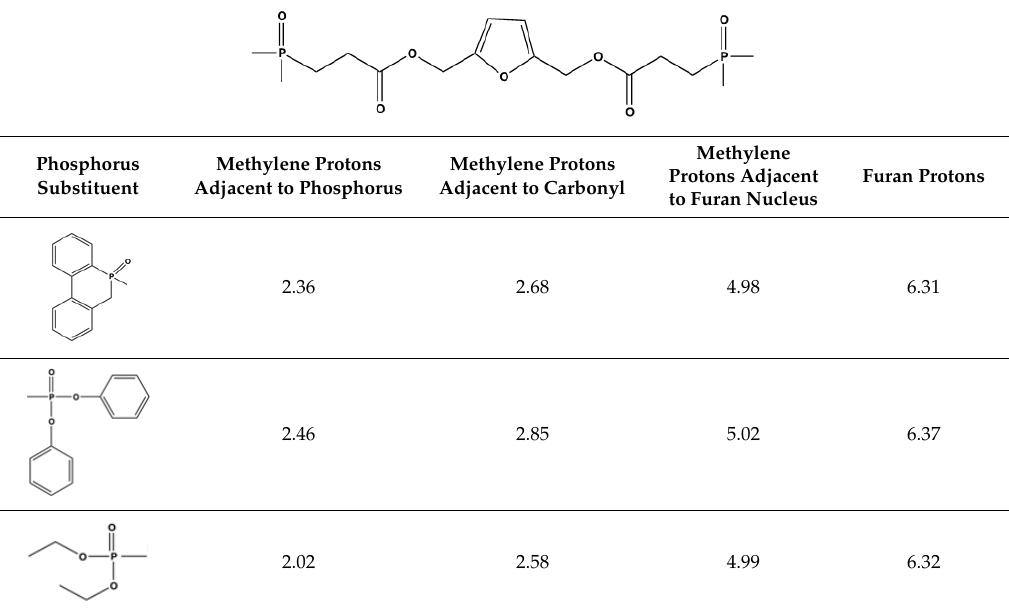
Table 3. Characteristic 13 C-NMR chemical shifts for phosphorus derivatives of 2,5- bis (Hydroxymethyl)furan diacrylate. a